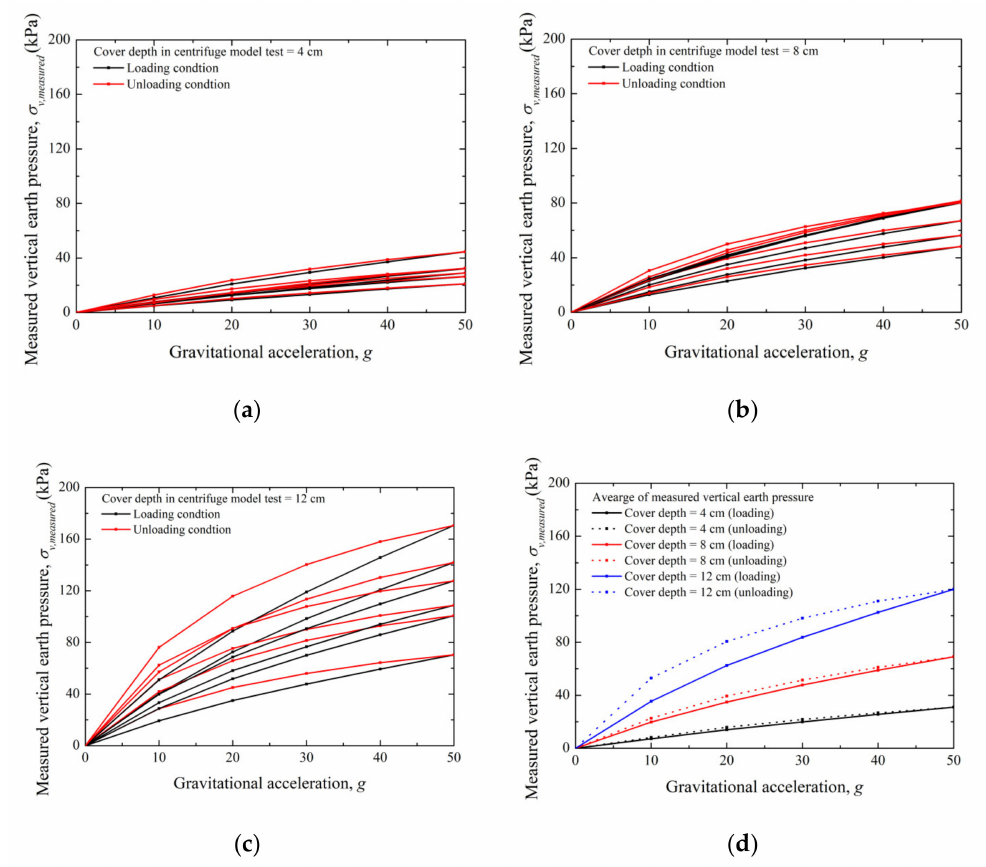
Figure 9. Measured vertical earth pressure under loading and unloading conditions; cover depth of ( a ) 4 cm, ( b ) 8 cm, ( c ) 12 cm, and ( d ) average of measured vertical earth